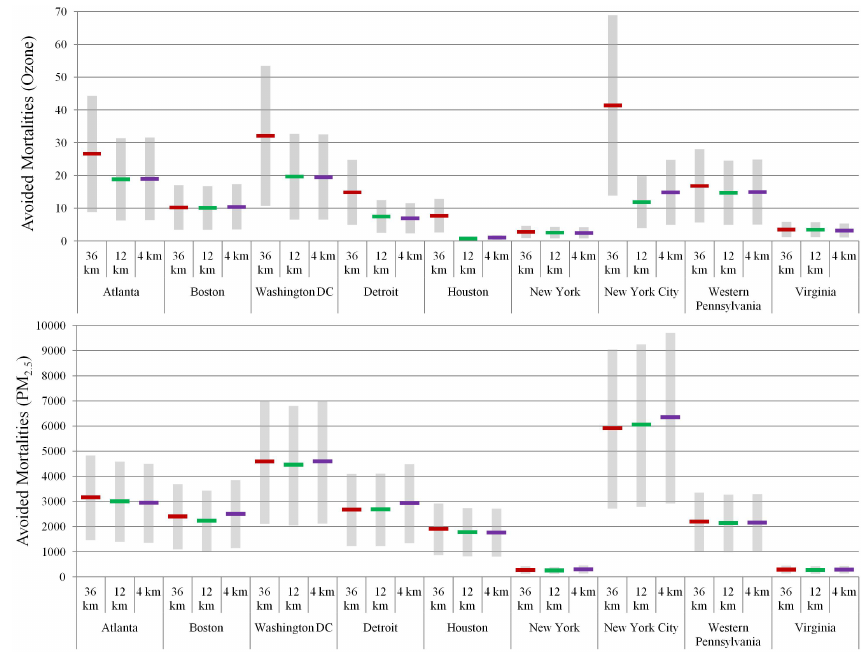
Fig. 2. (a) Mortalities avoided due to changes in ozone concentrations between the 2005 base case and the 2014 control case for each model resolution (red indicates 36km, green 12km, blue 4km), calculated using the concentration–response function developed by Bell et al. (2004). (b) Mortalities avoided due to changes in PM 2 . 5 concentrations between the 2005 base case and the 2014 control case for each model resolution (red indicates 36km, green 12km, blue 4km), calculated using the concentration–response function developed by Laden et al.